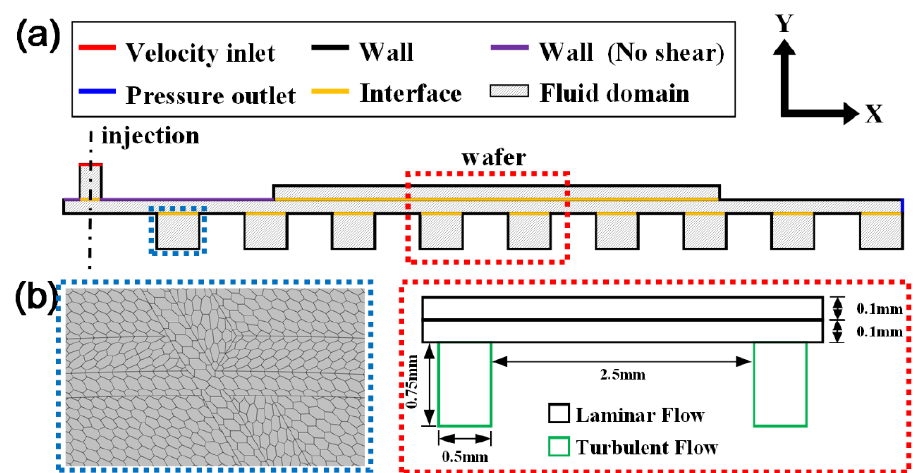
Figure 4. Schematic of the pad cross-sectional view in polishing: ( a ) the boundary conditions used in the simulation, and ( b ) the meshing and dimensions of the partial pad. Table 1. Fluid simulation settings.